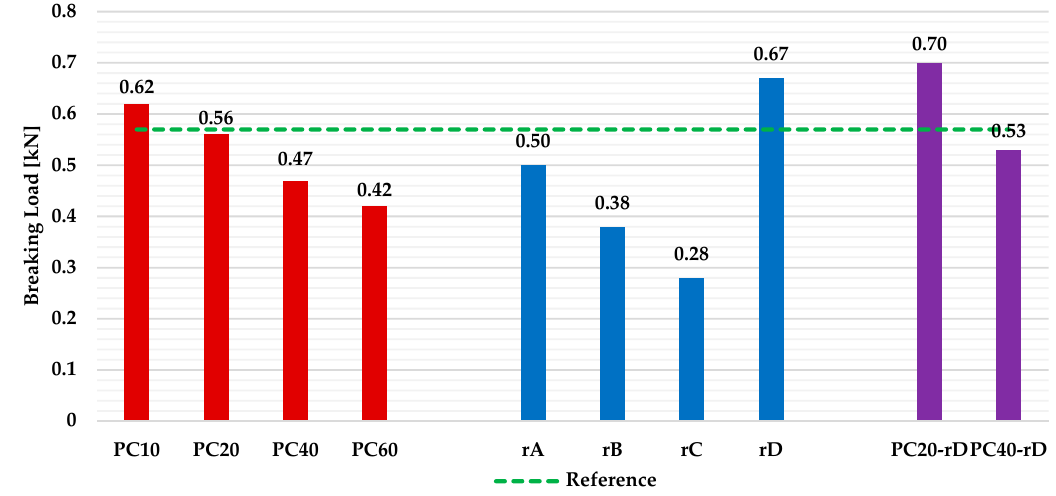
Figure 8. Breaking load results for all the scenarios (plates) under study.